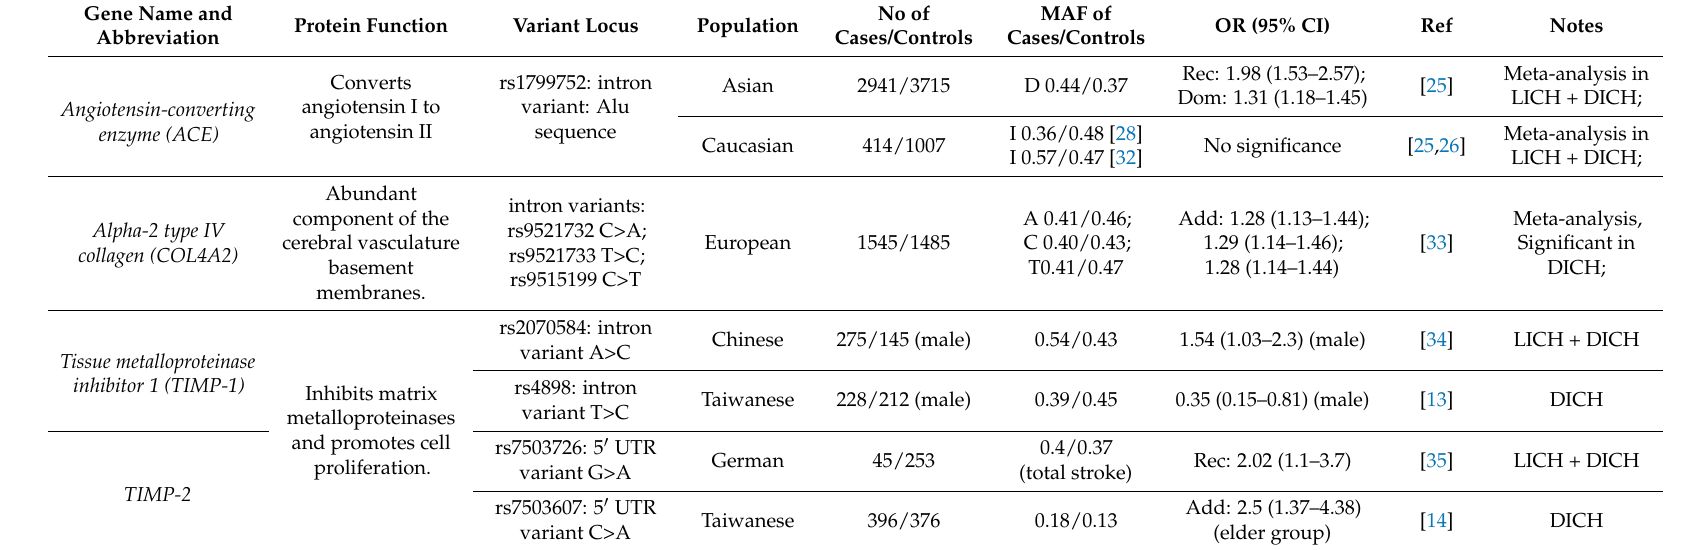
Table 1. Variants associated with spontaneous intracerebral hemorrhage (ICH): hypertension and vascular